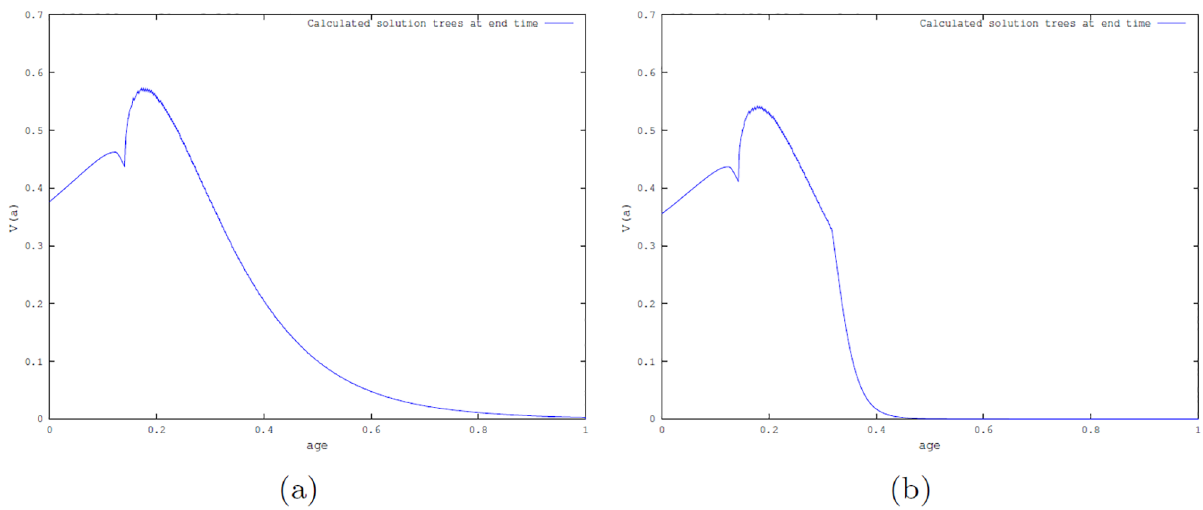
Fig 6. Simulation of the optimal control P2 using ω 1 = 1, ω 2 = .5 and u (a): when beetle population is at the endemic state; (b): when beetle population is at the epidemic state.